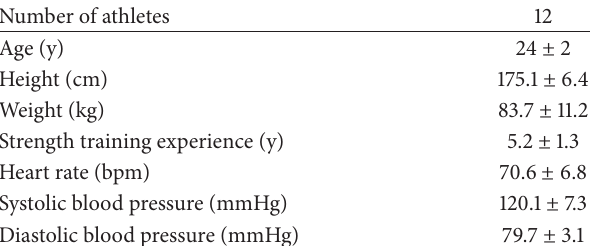
Table 1: Participants characteristics and resting